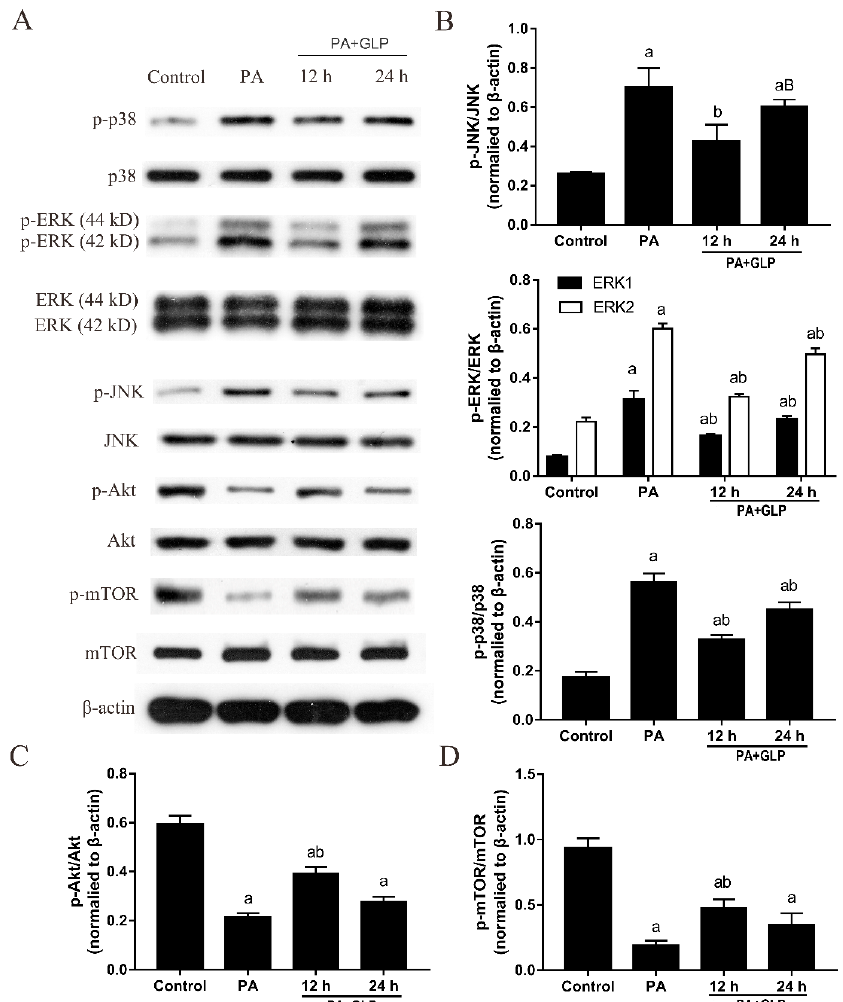
Figure 6. GLP activated Akt/mTOR signaling pathway and suppressed MAPK pathway in PA-induced IPEC-J2 cells. ( A ) Western blotting was used to analyze the protein expressions. ( B ) p-JNK/JNK, p-ERK/ERK, p-p38/p38, ( C ) p-Akt/Akt, and ( D ) p-mTOR/mTOR were calculated and presented. The data were quantified and normalized to β -actin. Data were presented as mean ± SE for three independent experiments ( n = 3), a < 0.01 vs. control, B < 0.05 and b < 0.01 vs. PA alone.